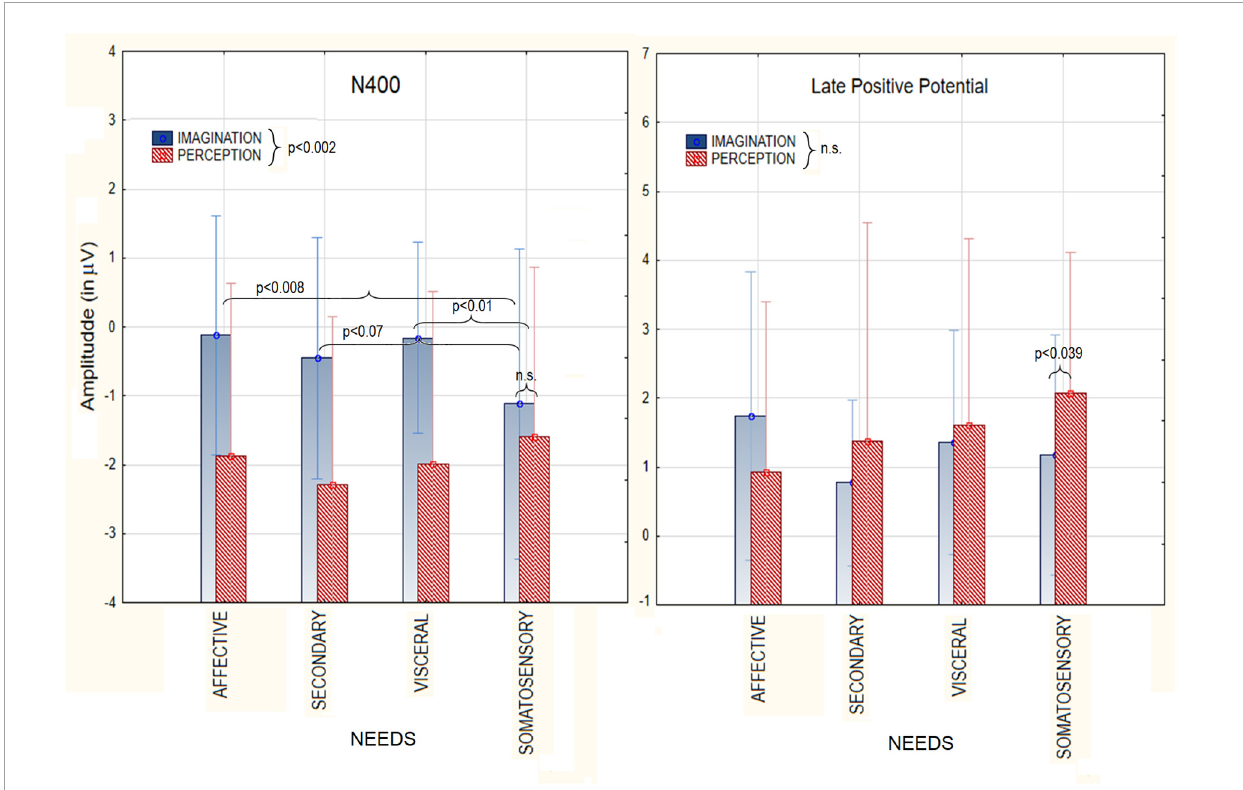
FIGURE3 Mean area amplitude values of N400 component (Left) and LPP (Right) as recorded during the perception and imagination conditions, as a function of the macro-category of